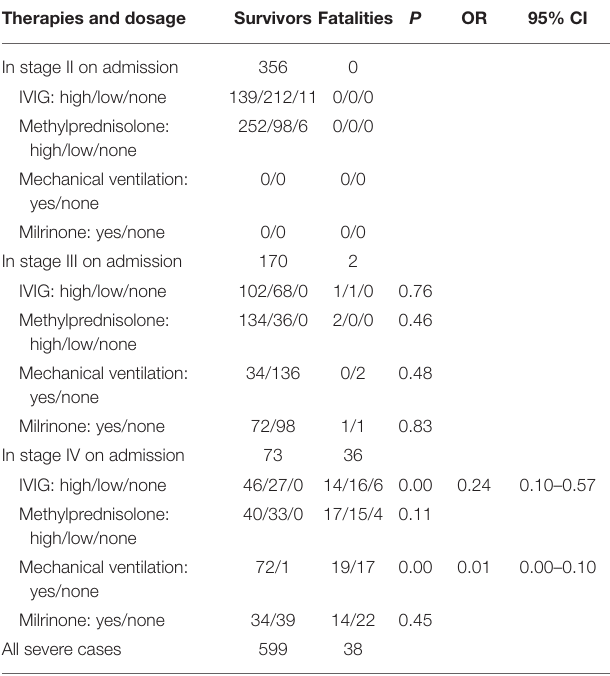
TABLE 3 | Efficiency comparison between different therapies and dosage administered in distinct stages. Therapies and